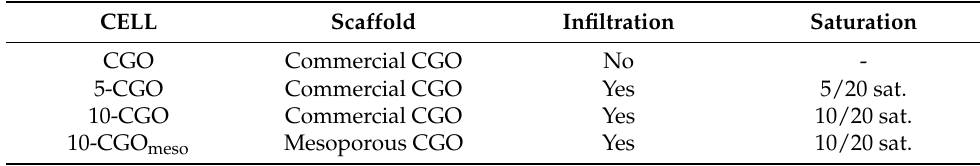
Table 1. Characteristics of the cells produced. Commercial YSZ tape ( ≈ 150 µ m) was used for all the fabricated cells. A barrier layer made of commercial CGO decorated by Co oxide was deposited and sintered at 1275 ◦ C. Commercial CGO scaffolds were sintered at 1250 ◦ C and the mesoporous CGO at 900 ◦ C. CELL Scaffold Infiltration